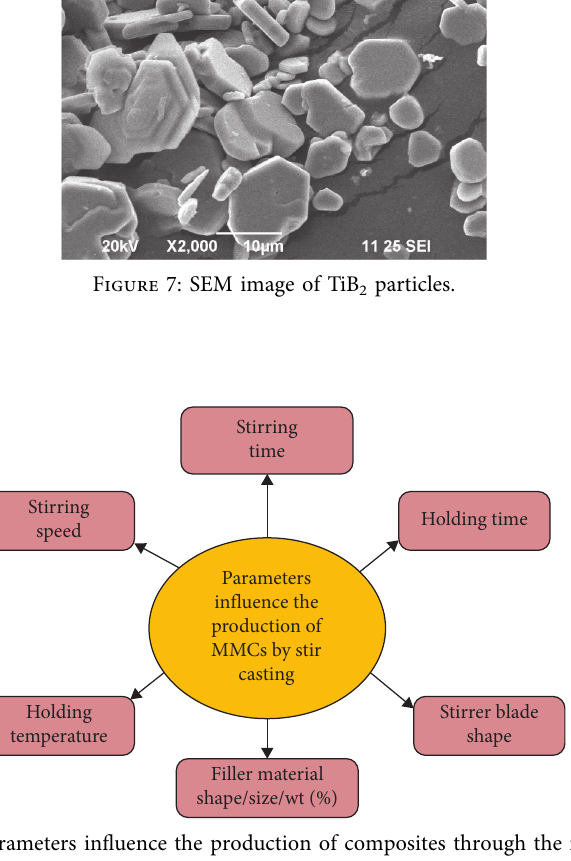
Figure 8: Process parameters influence the production of composites through the melt stirring